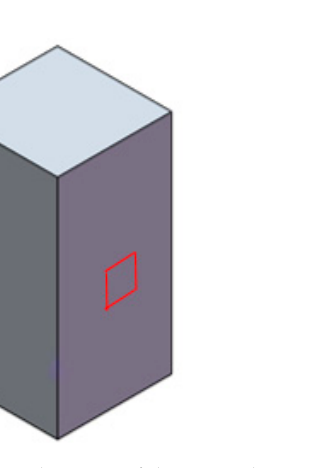
Figure 2. Schematic of the area where roughness was measured on the lateral wall of the cuboids.